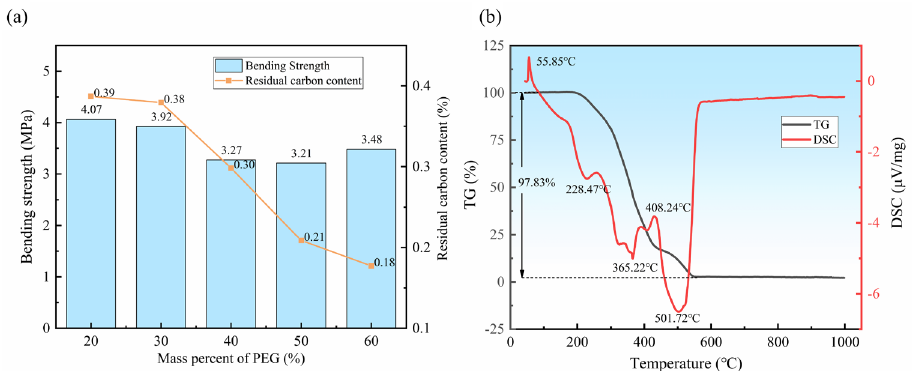
Figure 2. ( a ) The result of bending strength and carbon residue of rolling-slitting green part with different PEG mass fraction; ( b ) TG-DSC curves of binder polymers.